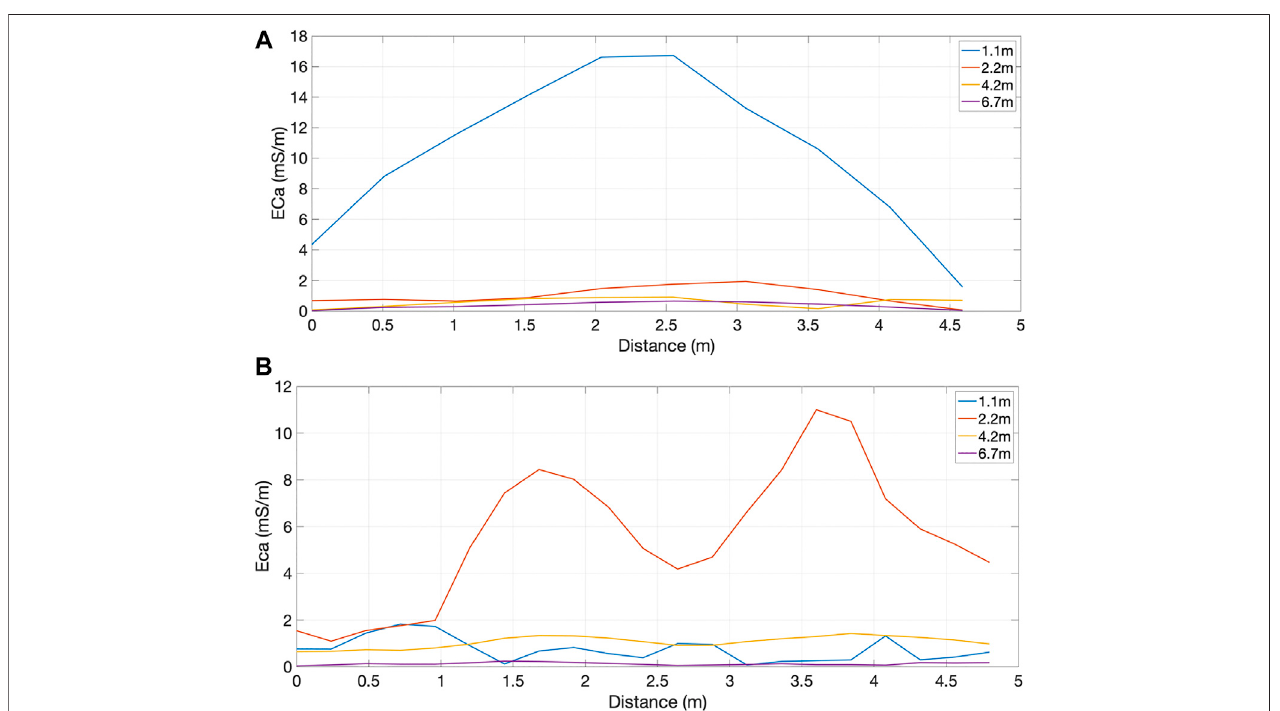
FIGURE 5 | Raw apparent electrical conductivity data (Eca) collected along the boreholes B2 (A) and B1 (B) .